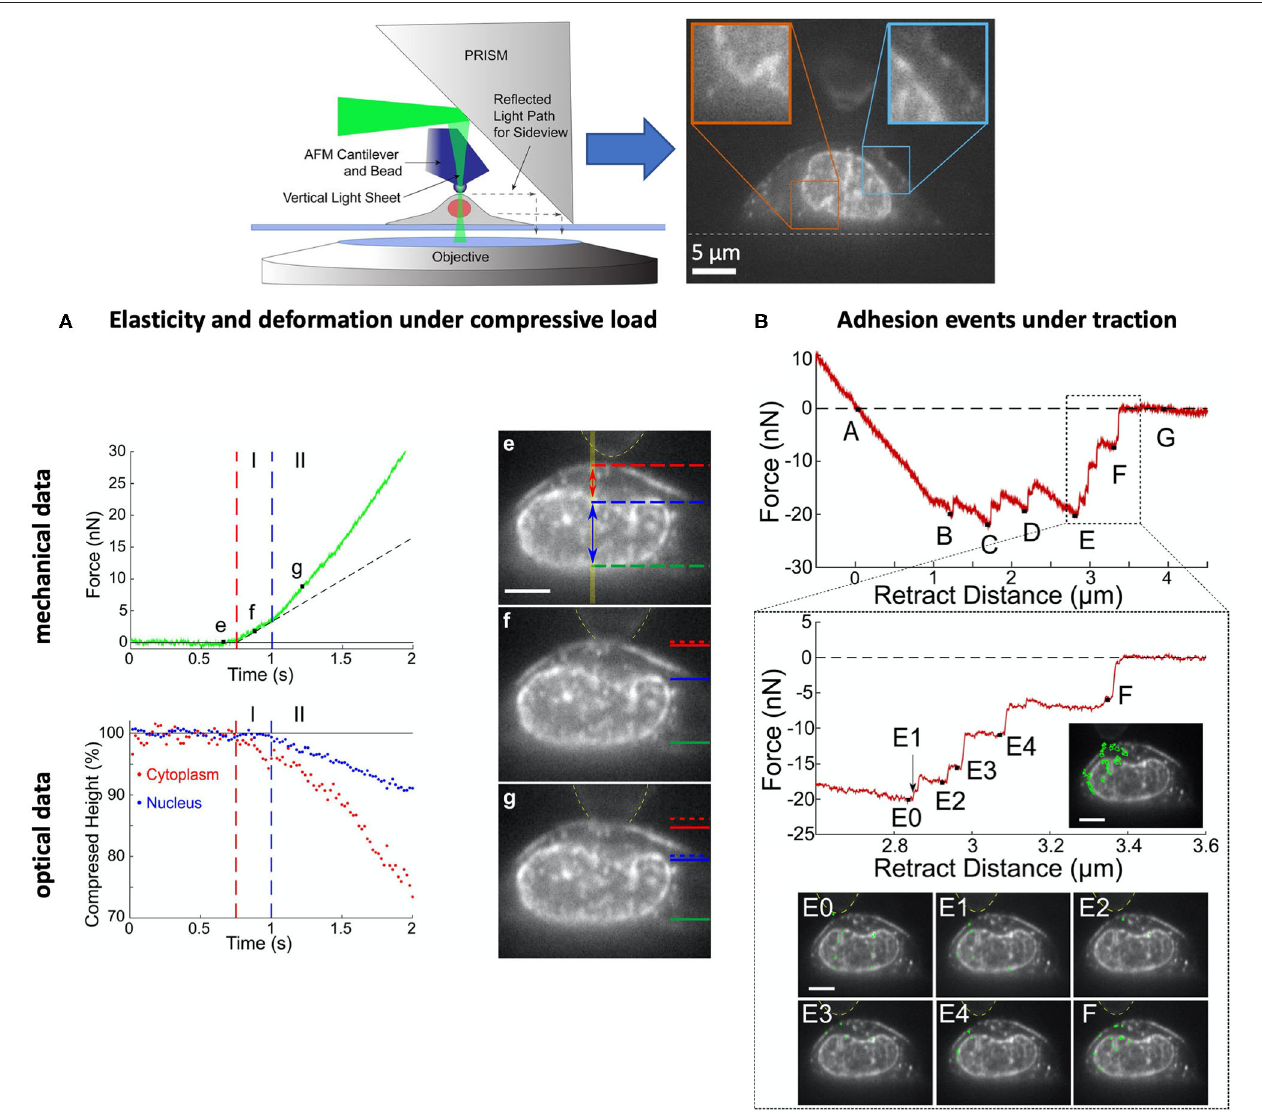
FIGURE 5 | Example of a scientific study based on a combination of AFM, pathway rotated imaging for sideways microscopy (PRISM) vertical light sheet illumination (VLS) for the synchronous detection of optical and mechanical events of single ovarian cancer cells (SKOV3). Inset on the top: experimental set-up. (A) The compression tests reveal two regimes, I and II, where the cell displays a stiffness of 2.9 and 3.9 kPa, respectively, and associated with the deformation of the cytoplasm (I) and the nucleus (II). (B) The decompression tests reveal a series of adhesion signatures (B–F) that can be associated to snap-off events between the membrane and the fibronectin-coated bead (B–E) and the membrane, nucleus and bead (E,F). The results evince a mechanical coupling between cell membrane and nucleus, a type of interconnection that mediates cell adhesion. [Figures reproduced from (Beicker et al., 2018) with permission 1